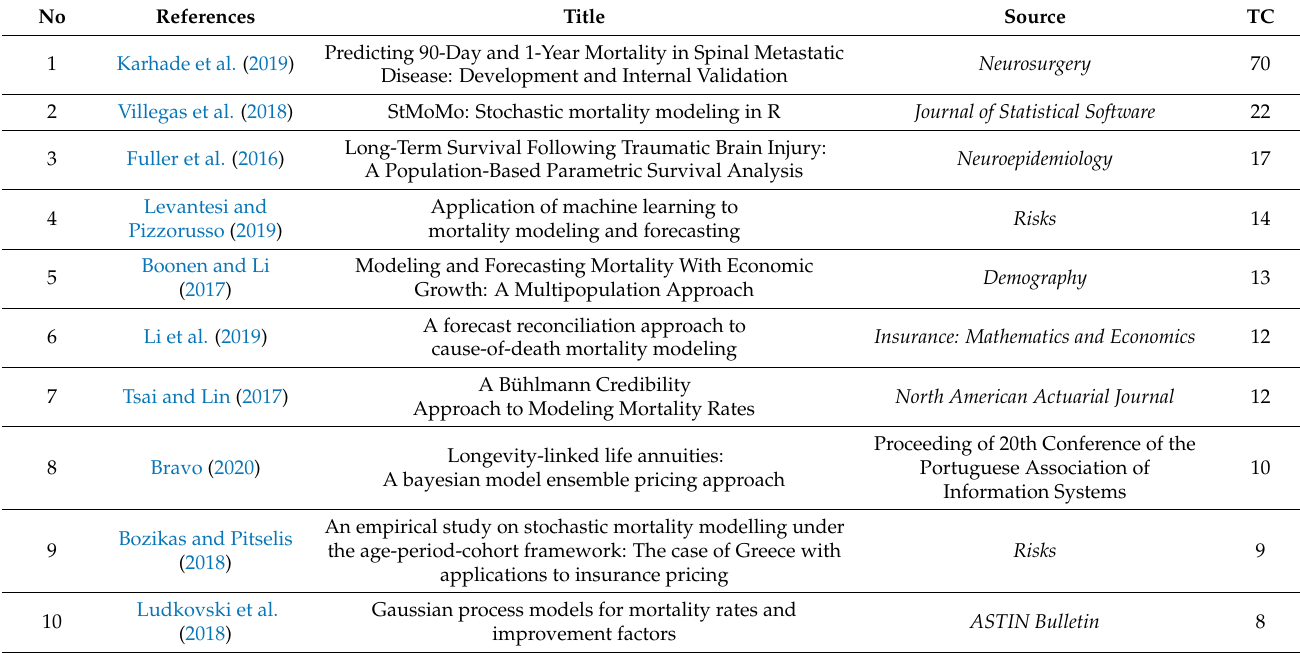
Table 5. Top 10 most cited documents between 2016 and